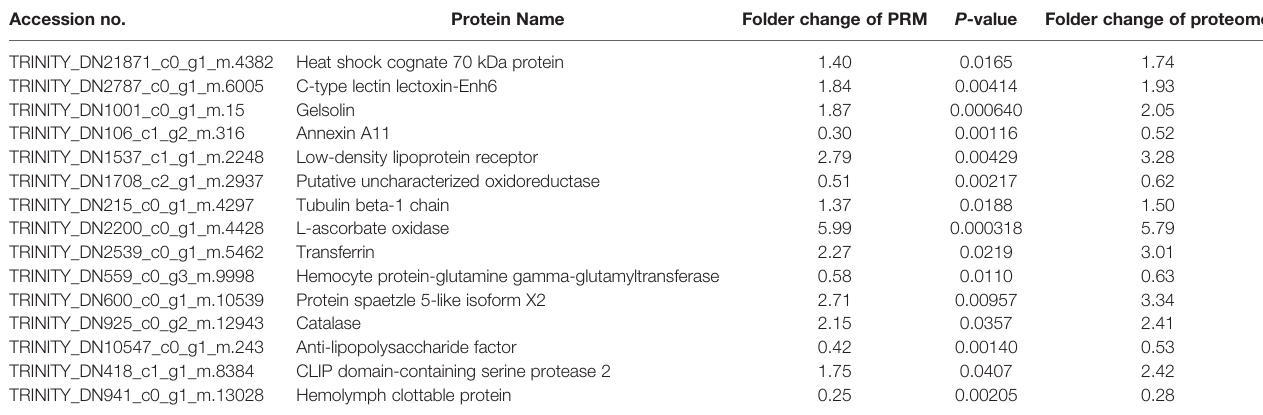
TABLE 2 | Relative expression levels of selected proteins measured via parallel reaction monitoring (PRM). Accession no. Protein Name Folder change of PRM Folder change of